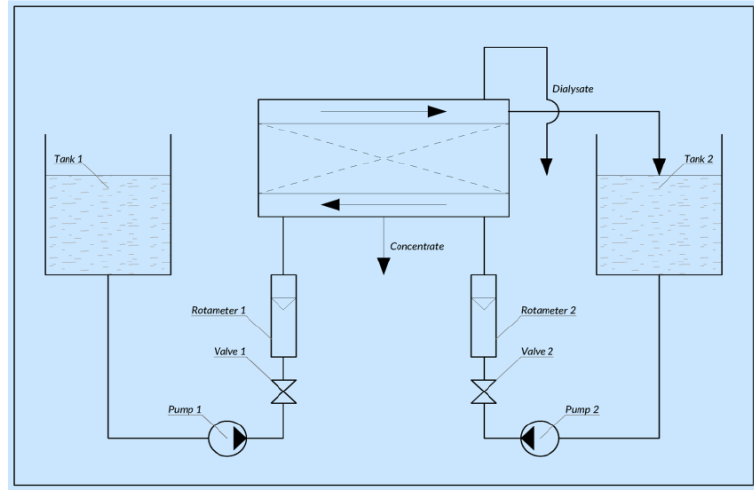
Figure 6. Scheme of the process for adjusting the pH of technological solutions.